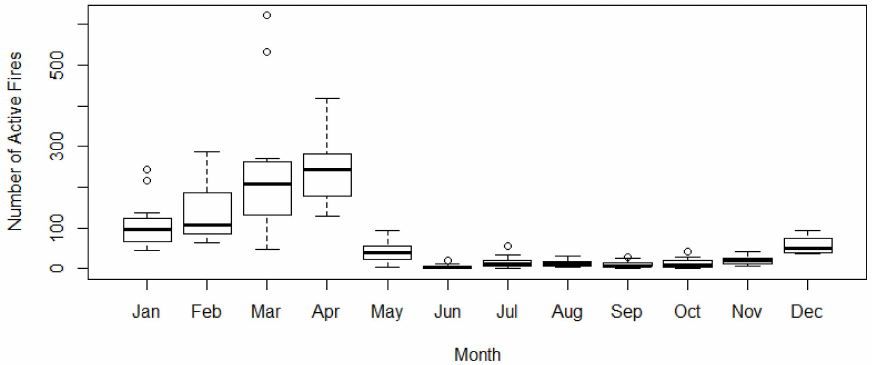
Figure 5. Monthly boxplots of satellite detected active fires in El Salvador between 2001 and